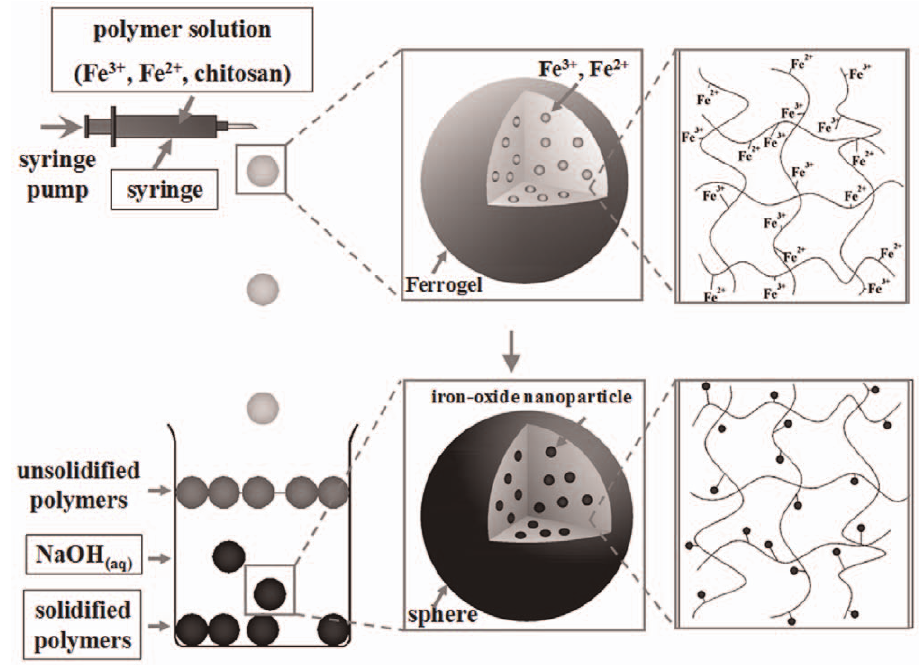
Figure 1. Schematic of the formation process of macroporous chitosan spheres.